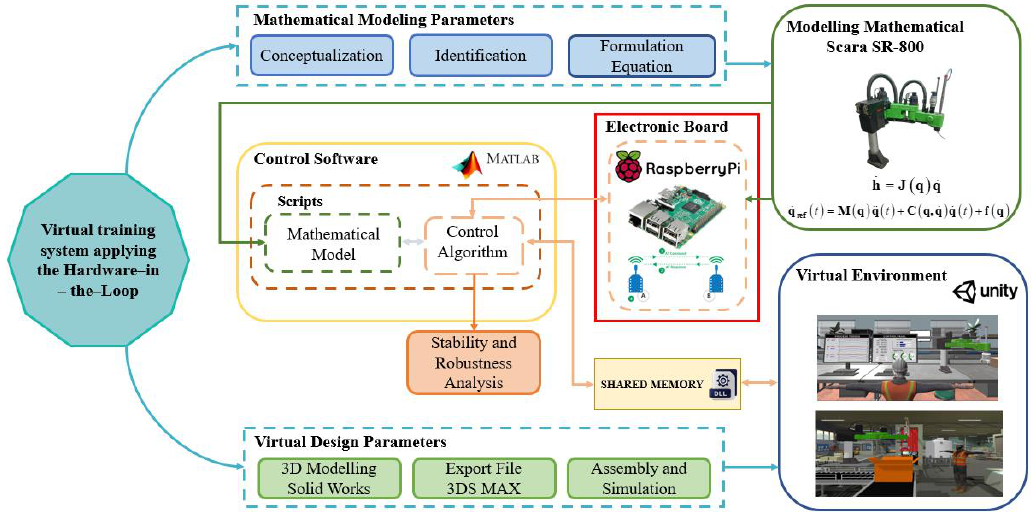
Figure 2. Methodology for the control and virtualization of the Scara SR-800 Robot.